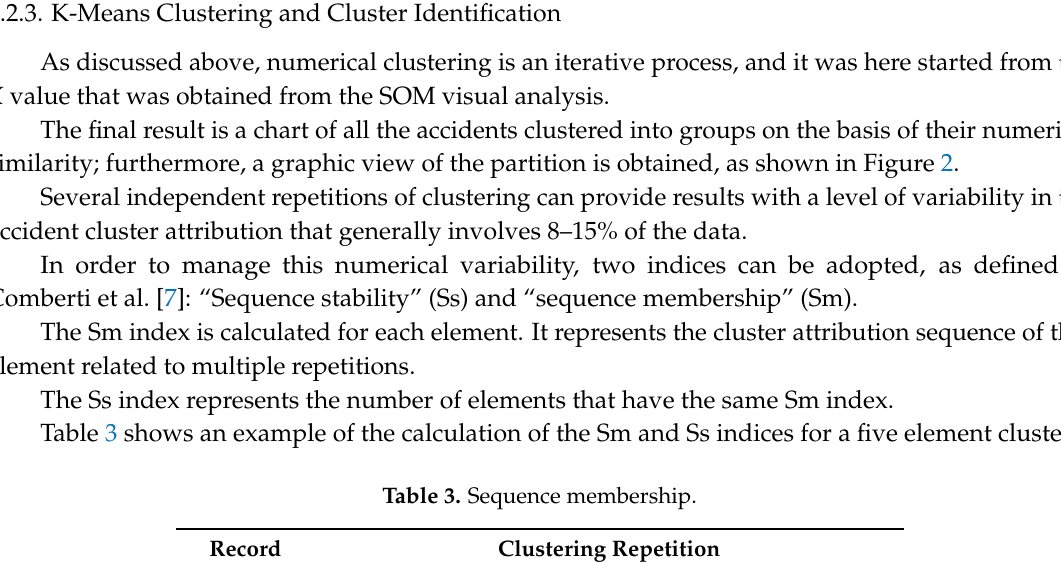
Figure 3. Self Organizing Map (SOM) of the Accident Matrix (AM) matrix based on 10,000 units.